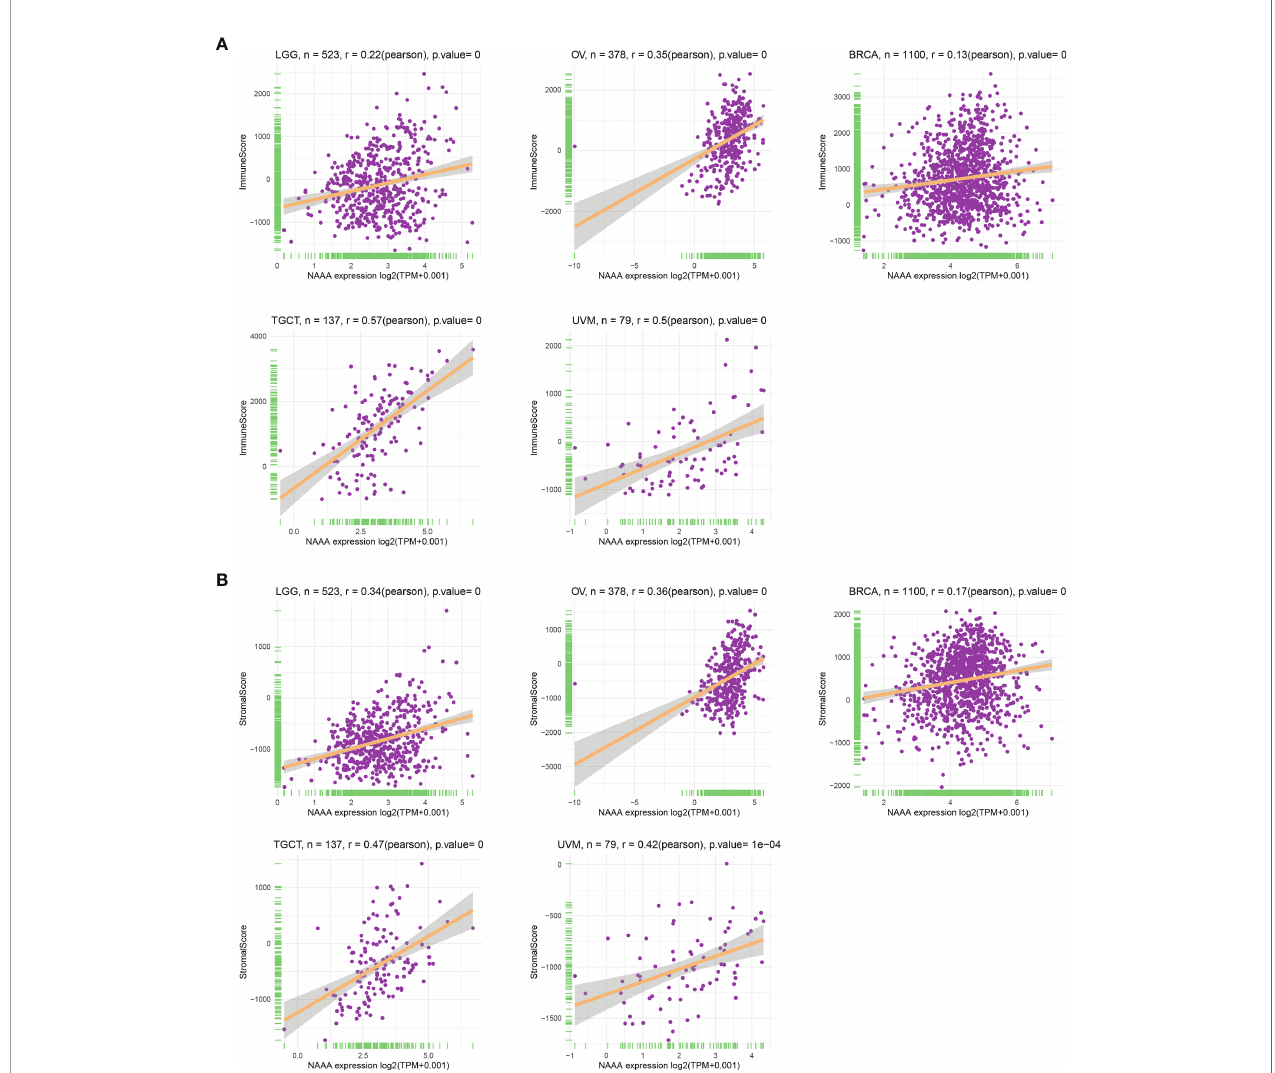
FIGURE 9 | Relationship of NAAA expression with stromal score and immune score in fi ve cancers. NAAA expression has a signi fi cantly positive correlation with the StromalScore (A) and ImmuneScore (B) in LGG, OV, BRCA, TGCT, UVM. BRCA, breast invasive carcinoma; LGG, brain lower grade glioma; UVM, uveal melanoma; OV, ovarian cancer; TGTC, testicular germ cell